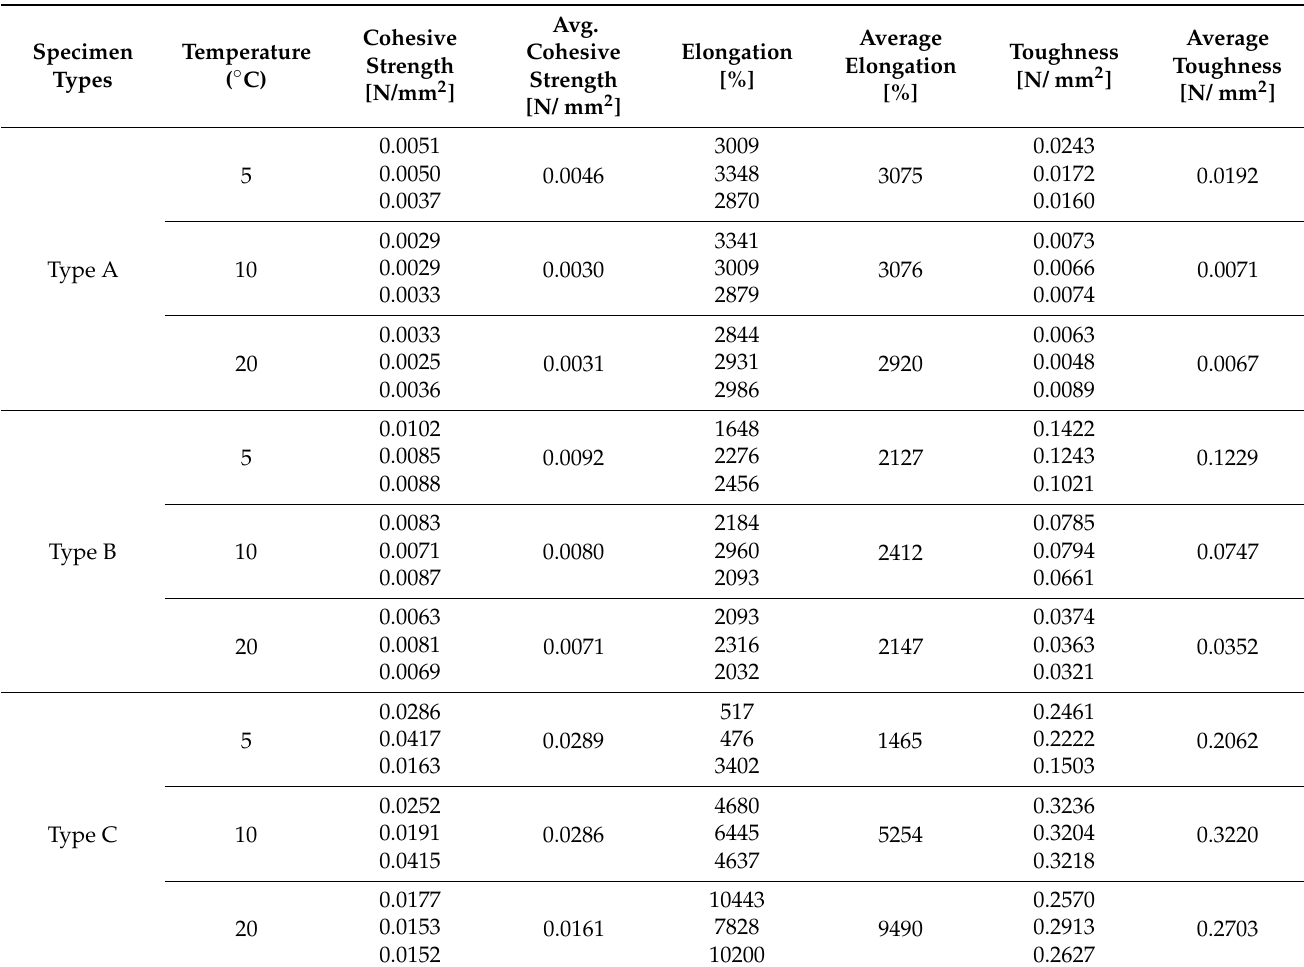
Table 4. Measurement result based on specimen types (10 mm